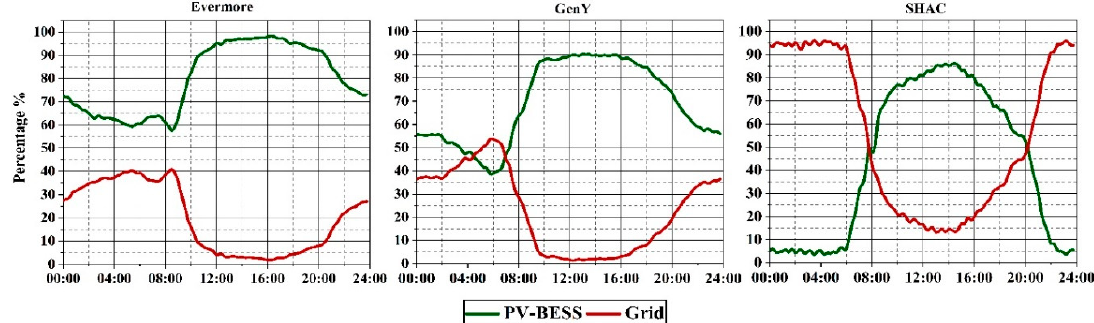
Figure A1. Averaged diurnal share of sources.